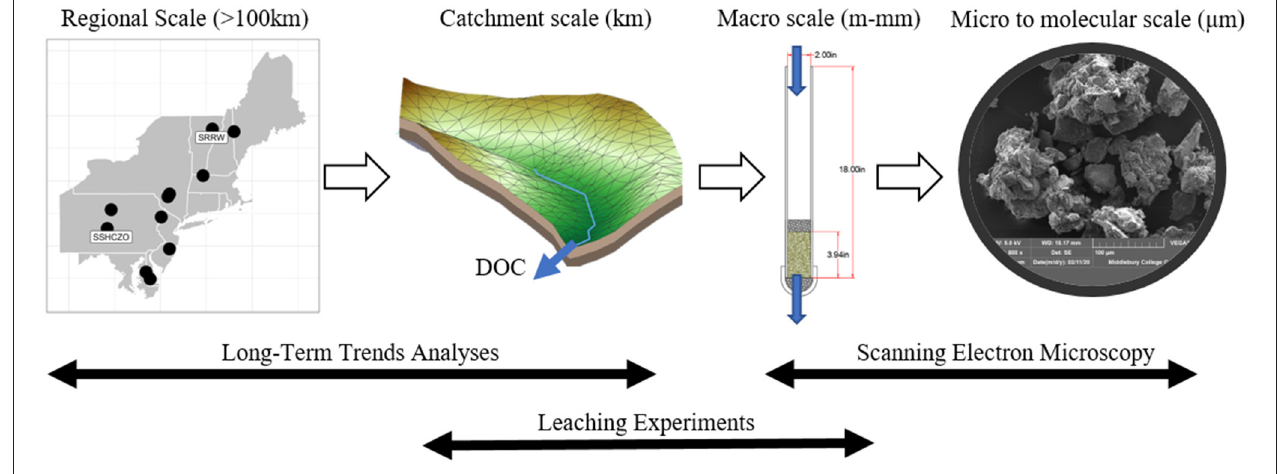
FIGURE 1 | Conceptual depiction of investigated